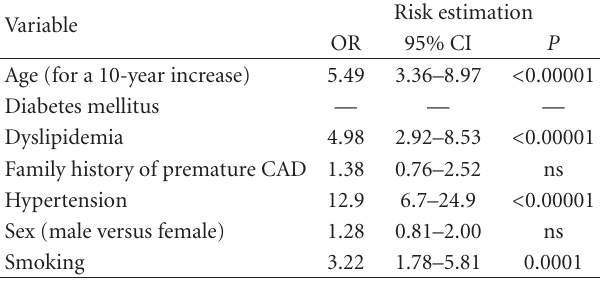
Table 3: E ff ect of conventional risk factors on the probability